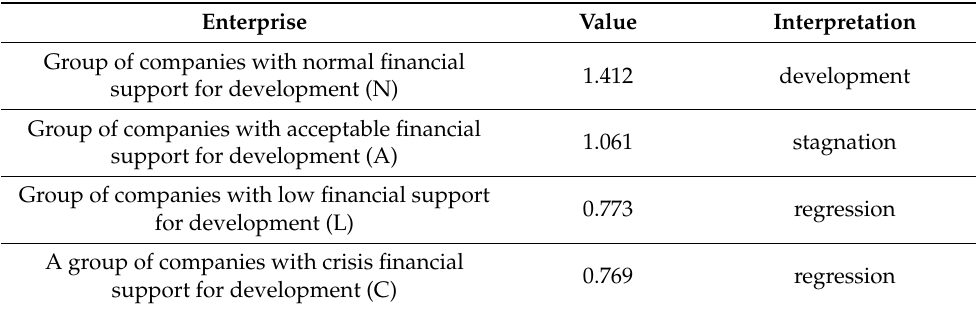
Table 5. Integral development indicators (IDI) of researched textile enterprises groups and their interpretation.